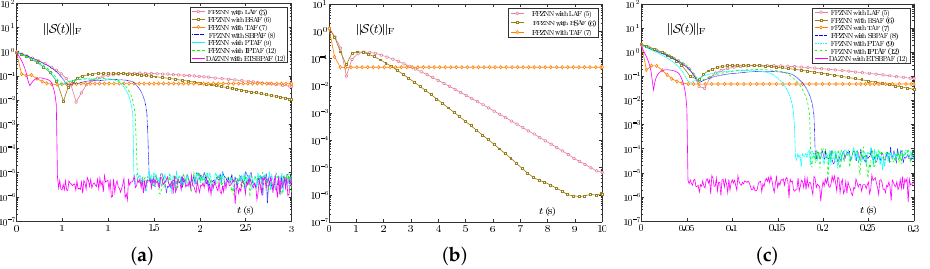
Figure 2. Dynamic characteristics of the (cid:107)S ( t ) (cid:107) F by FPZNN model (4) and DAZNN model (14) with no noise and different λ 1 = λ 2 . ( a ) With λ 1 = λ 2 = 1.5. ( b ) With λ 1 = λ 2 = 1.5. ( c ) With λ 1 = λ 2 =